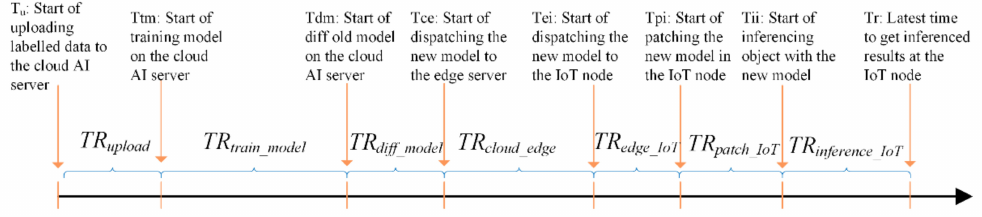
Figure 4. The timing diagram of the Cloud-Edge-SmartIot